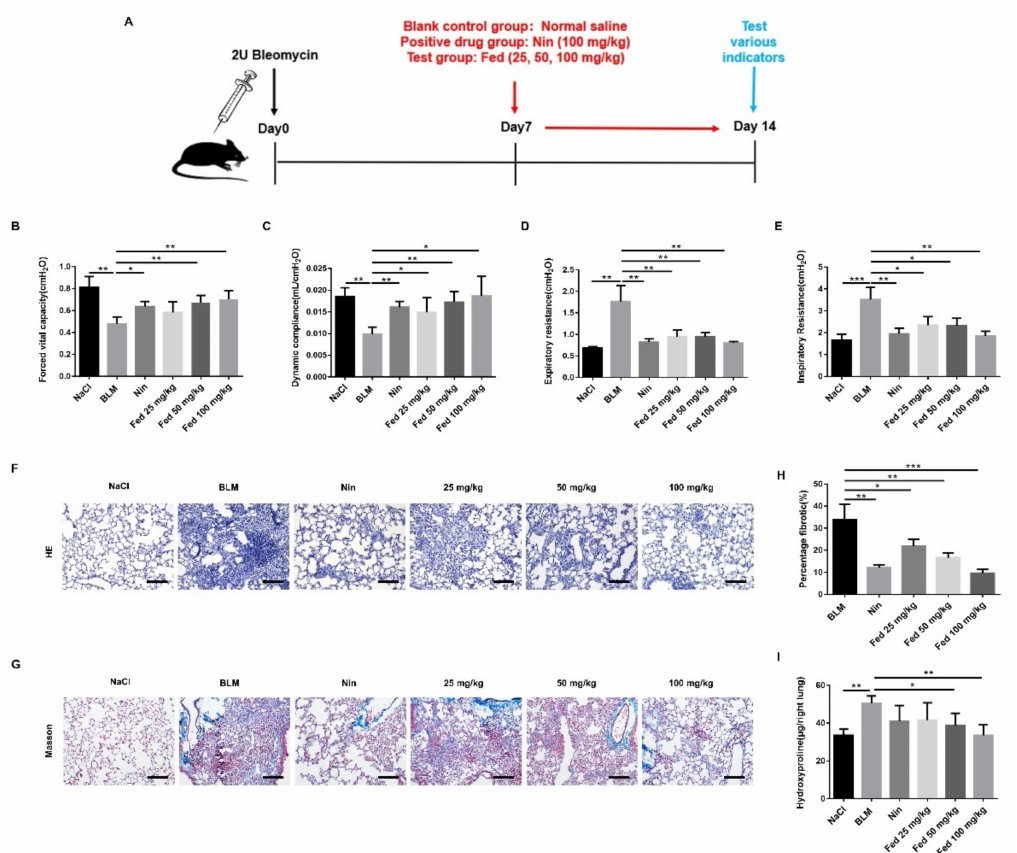
Figure 6. Influence of fedratinib on bleomycin-induced lung fibrosis. ( A ) Dosing regimen in BLM-induced pulmonary fibrosis model. ( B ) Forced vital capacity (FVC). ( C ) Dynamic compliance (Cdyn). ( D ) Expiratory resistance (Re). ( E ) Inspiratory resistance (Ri). ( F ) Lung tissue sections were stained with hematoxylin and eosin staining (H&E). ( G ) Lung tissue sections were stained with Masson trichrome staining. ( H ) Statistics of lung fibrosis area among groups. ( I ) Hydroxyproline (HYP) contents of lung tissues in mice. Scale bar = 50 µ m. Data are presented as the means ± SD ( n = 8). Comparisons between groups were achieved using one-way analysis of variance (ANOVA). * p < 0.05, ** p < 0.01, *** p <